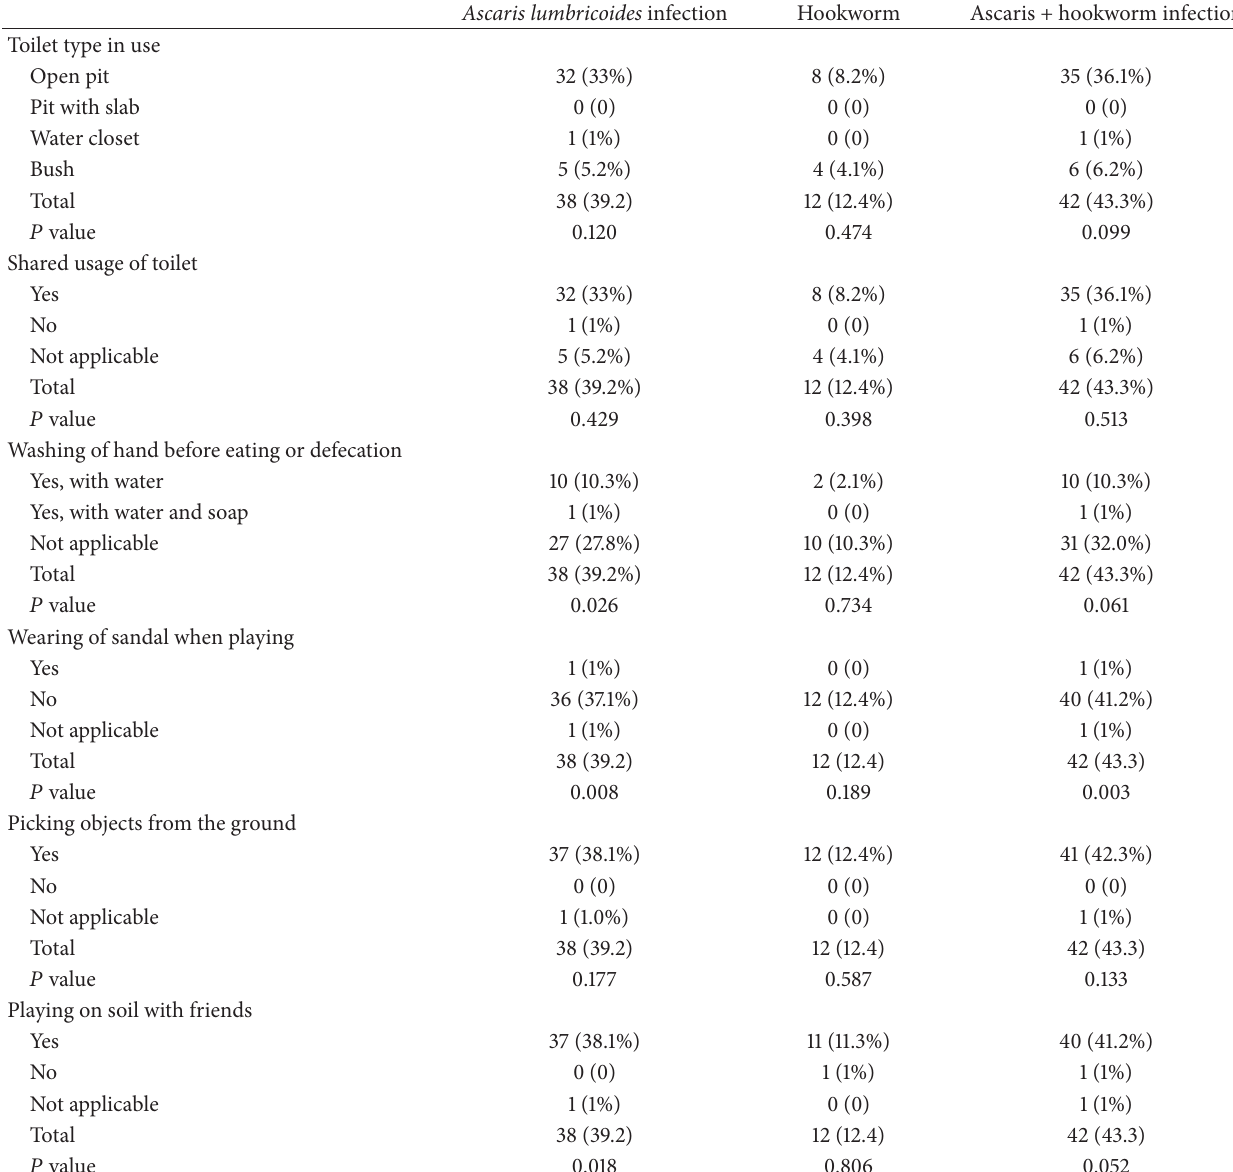
Table 10: Prevalence of geohelminth infections and associated risk factors. Ascaris lumbricoides infection